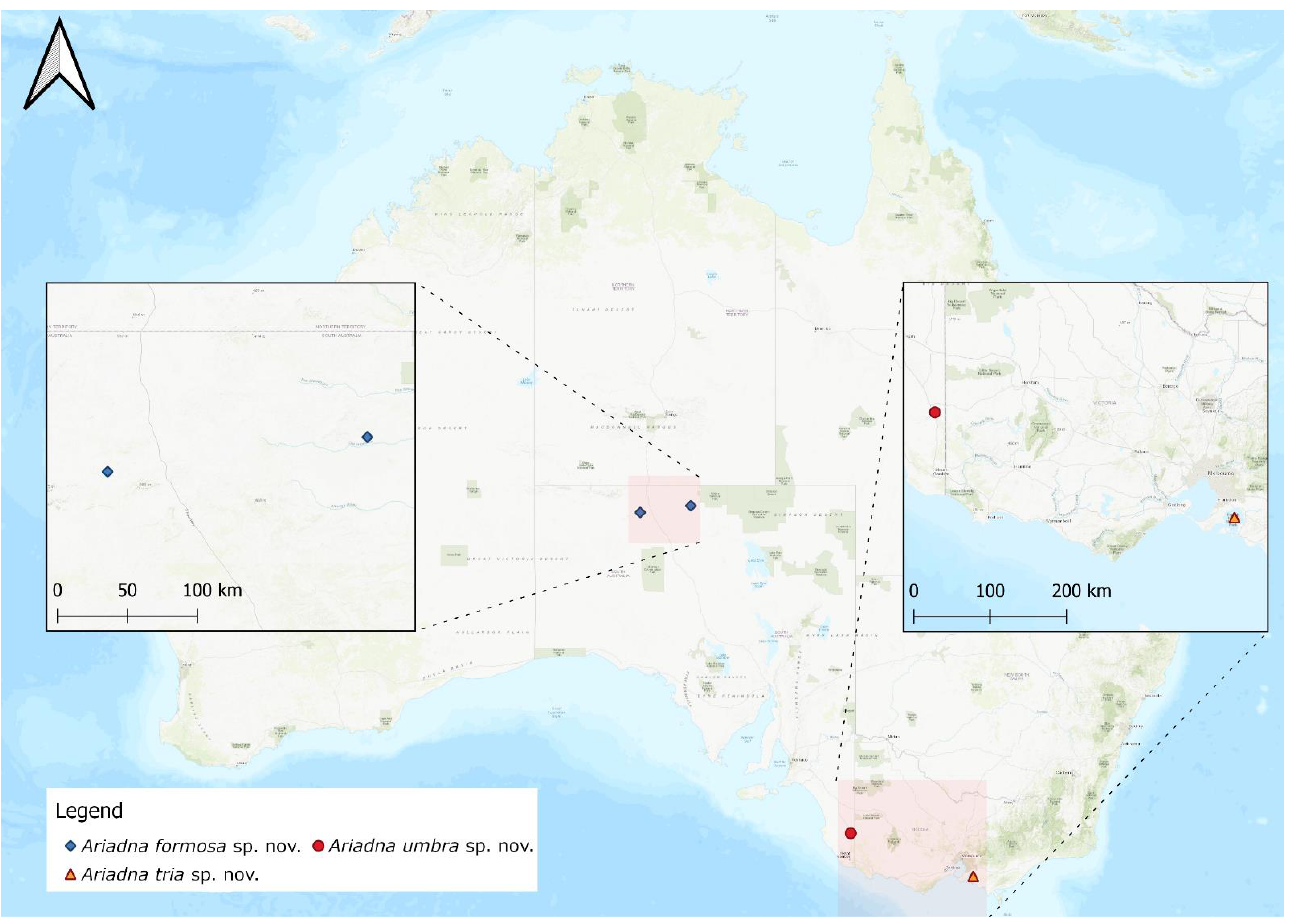
Figure 19. Map showing the currently known distribution of A. formosa sp. nov., A. tria sp. nov. and A. umbra sp. nov.